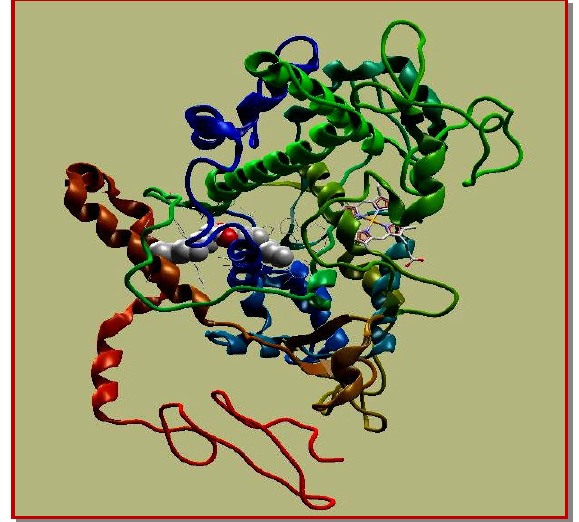
Figure 2: Binding mode of cannabigerol penetrated deeply into active site of COX-2